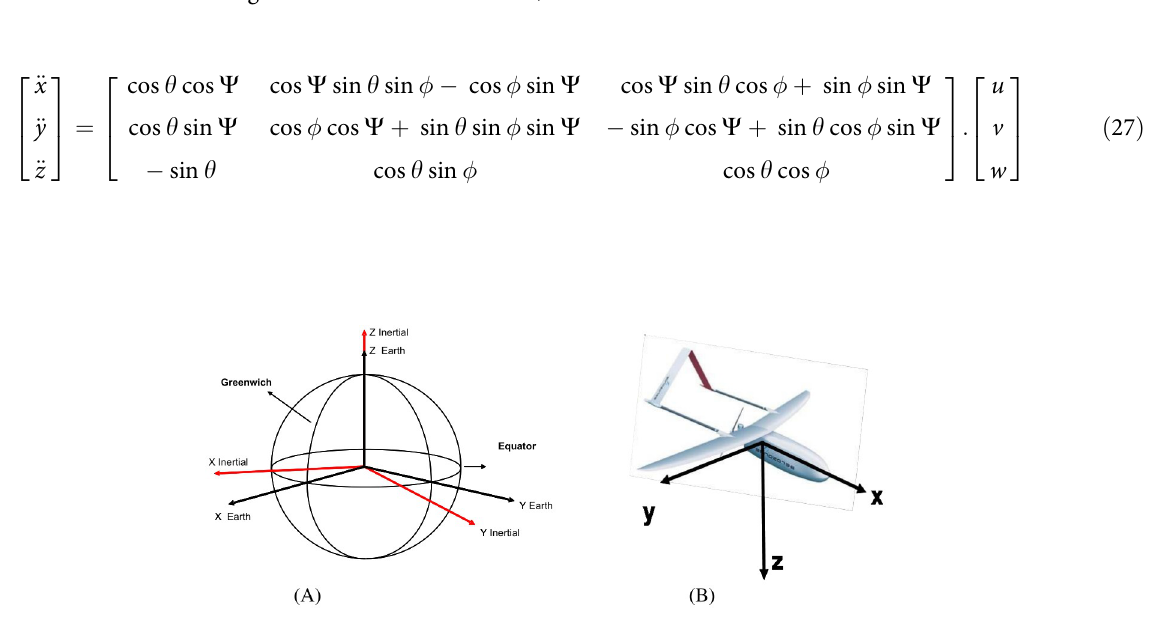
Fig 4. Coordinate systems. (A) Earth-centered fixed plane. (B) UAV body frame